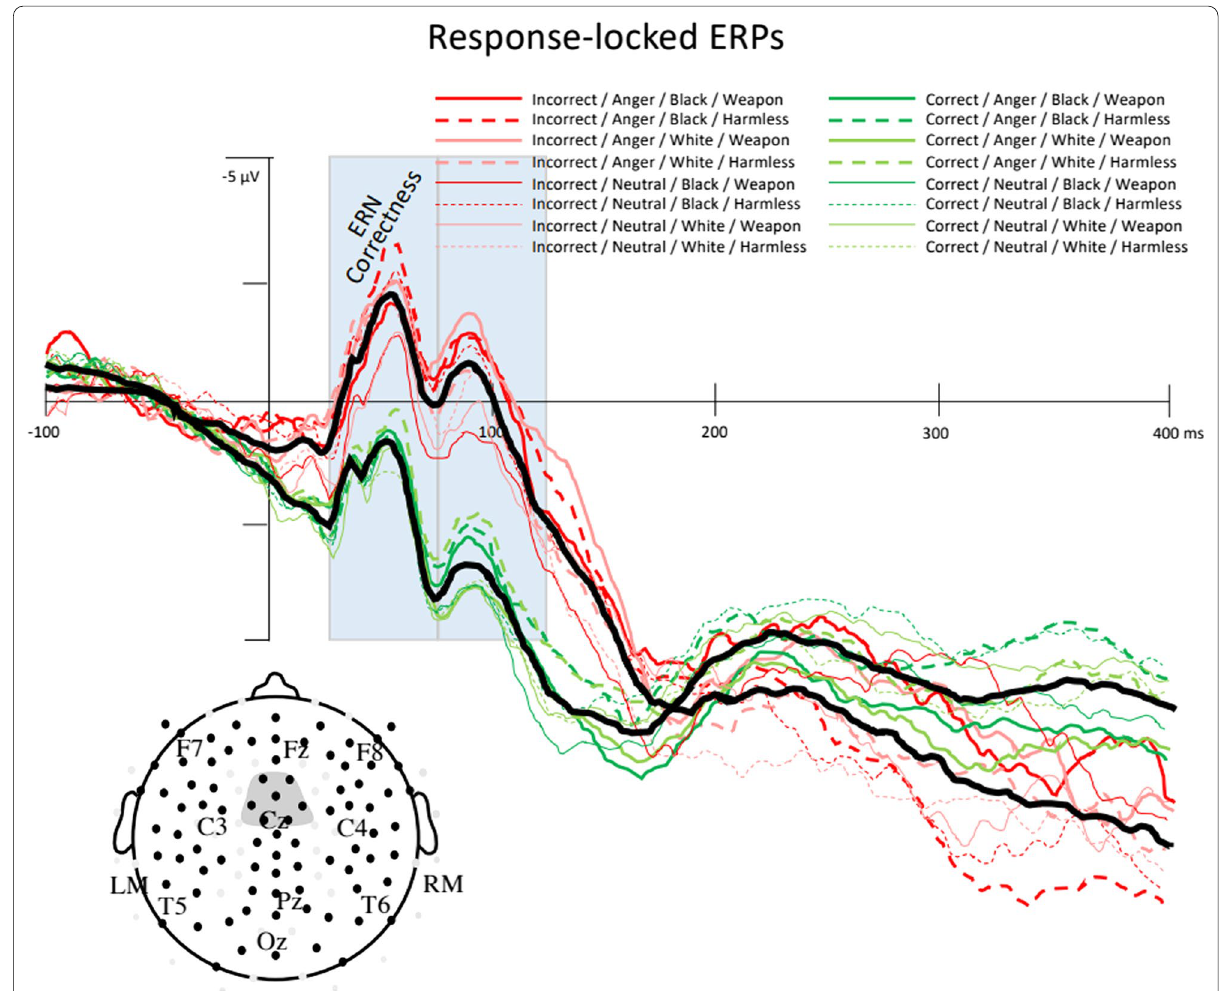
Fig. 5 ERP waveforms time‑locked to a response at medial anterior‑central electrodes only. Correctness is distinguished by line color (incorrect red, correct green); Emotion condition is distinguished by line thickness (anger = = distinguished by line shading (Black darker, White lighter); Object type is distinguished by line type (weapon = = black lines show waveforms averaged across all Correct conditions and all incorrect conditions. Incorrect responses elicited a larger negativity than correct responses in the ERN time window (25–75 ms after response) that carried over into the subsequent time window (75–125 ms after response), with no evidence of modulation by Emotion, Race prime, or Object type